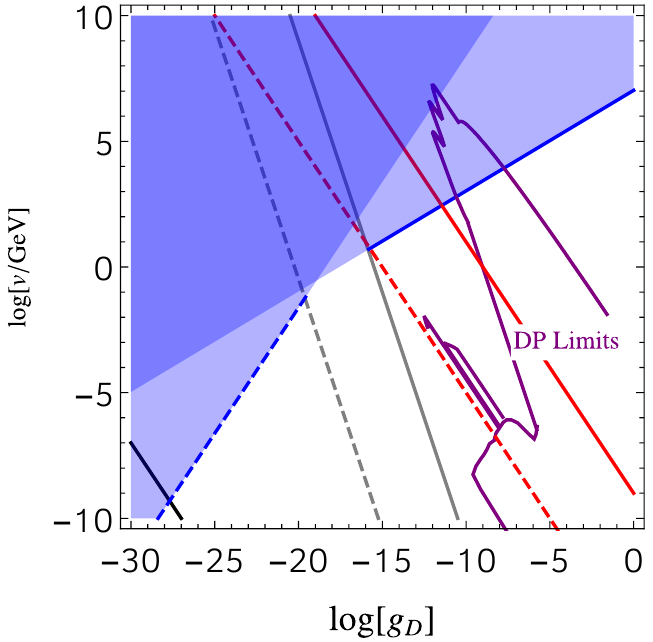
Figure 16 . The observational consequences of a network of string bundles that radiates predom- inantly longitudinal mode dark photons. The blue shaded region is excluded by overclosing the universe on the right, and N eff constraints on the left [72]. The blue solid line is when dark photons make up all of dark matter, while the blue dashed line corresponds to when relativistic dark photons have the same energy density as photons today. The red solid and dashed lines correspond to when the mass of the dark photon is eV and GHz ( ∼ 10 − 6 eV), respectively. The gray solid and dashed lines show when the dark photon radiation becomes non-relativistic at, respectively, cosmic temperatures of T γ = keV and today. In the region between the gray solid and dashed lines, dark photon radiation becomes non-relativistic during the time of CMB and structure formation, and the constraint depends on the details of the spectral shape of dark photons emitted by the string network. Below the black solid line, the dynamics we discuss here occur after matter-radiation equality. The parameter space to the bottom right of the purple solid line is excluded by the existing solar, CMB, and ADMX constraints [74] if the kinetic mixing is generated at one loop as in [1], i.e. (cid:15) = eg D / 16 π 2